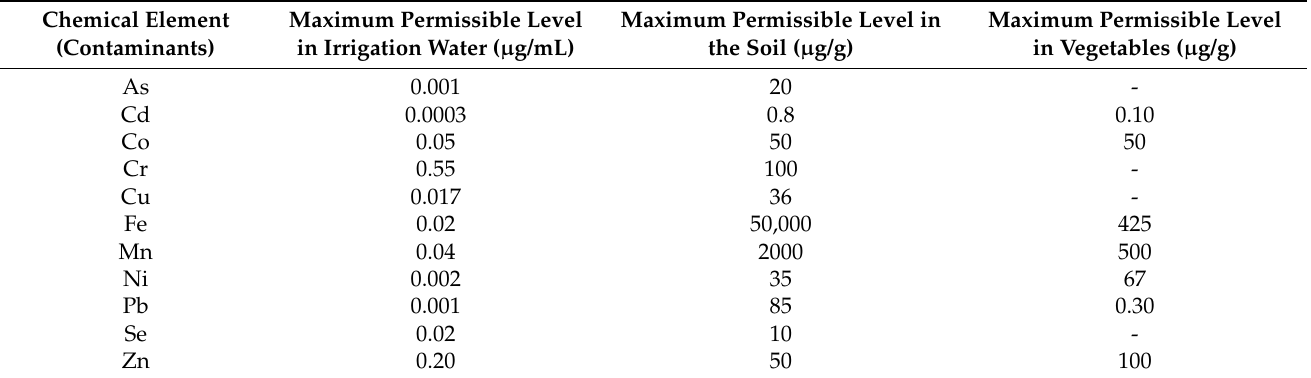
Table 1. Maximum permissible limits of heavy metals and other pollutants in irrigation water, soils, and vegetables